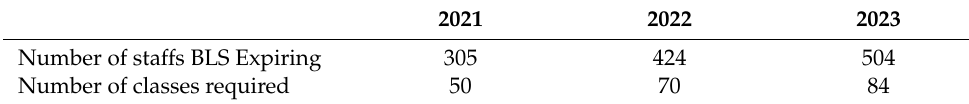
Table 7. Forecasted of required BLS